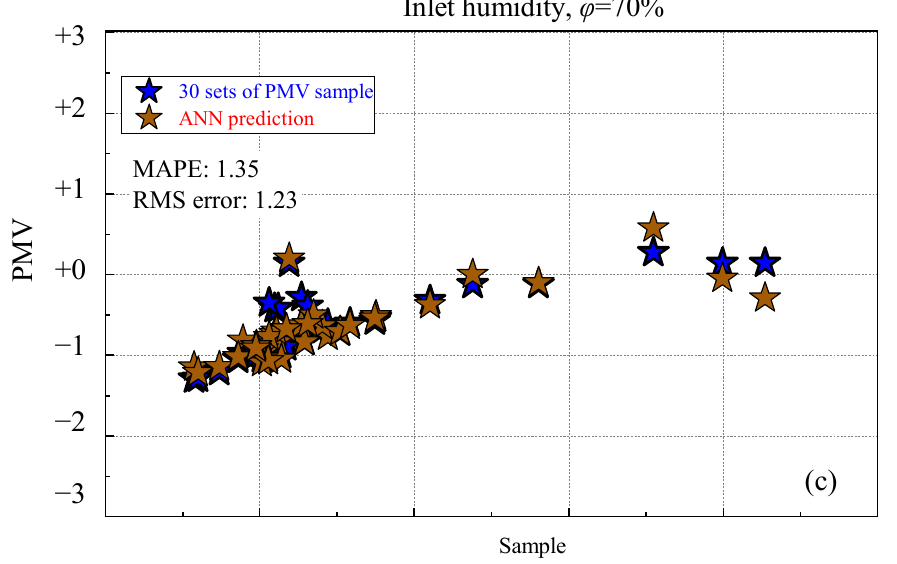
Figure 26. Prediction performance of the ANN model for selected data points: ( a ) Case 1; ( b ) Case 2; ( c ) Case 3.